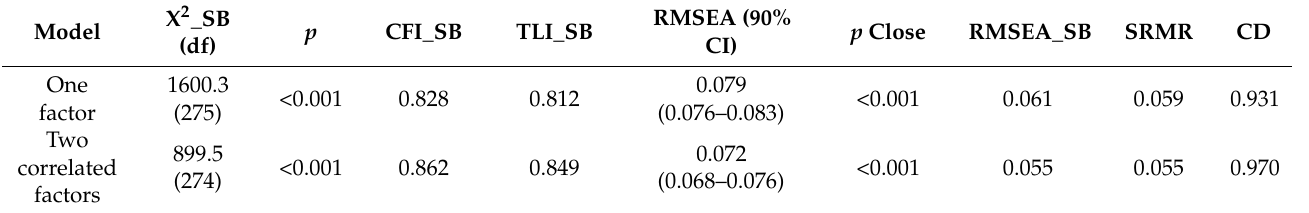
Table 3. Fit indices in the studied factor models.